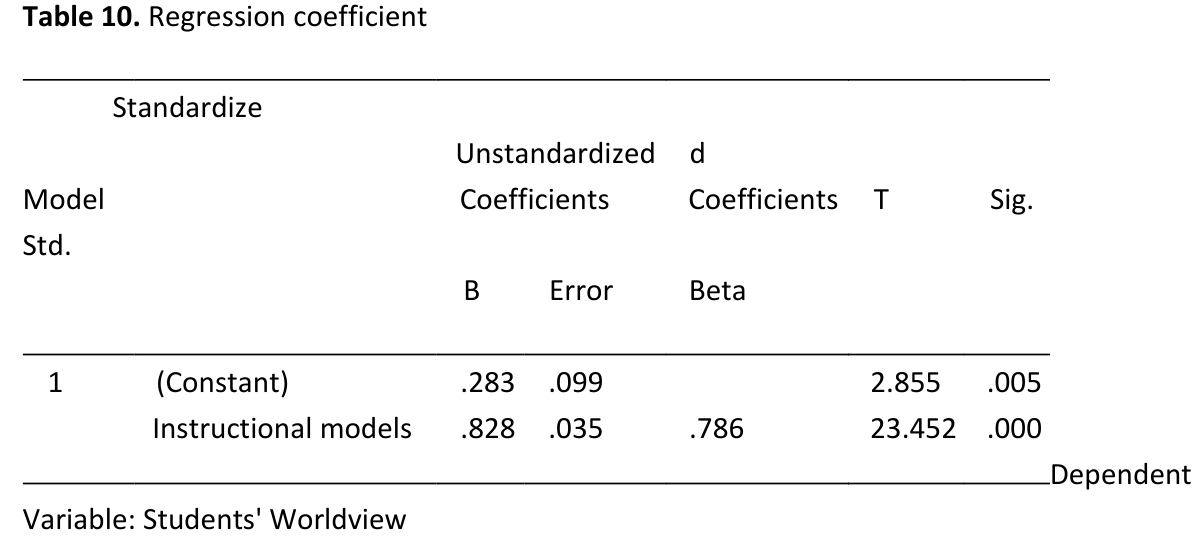
Table 10. Regression coefficient